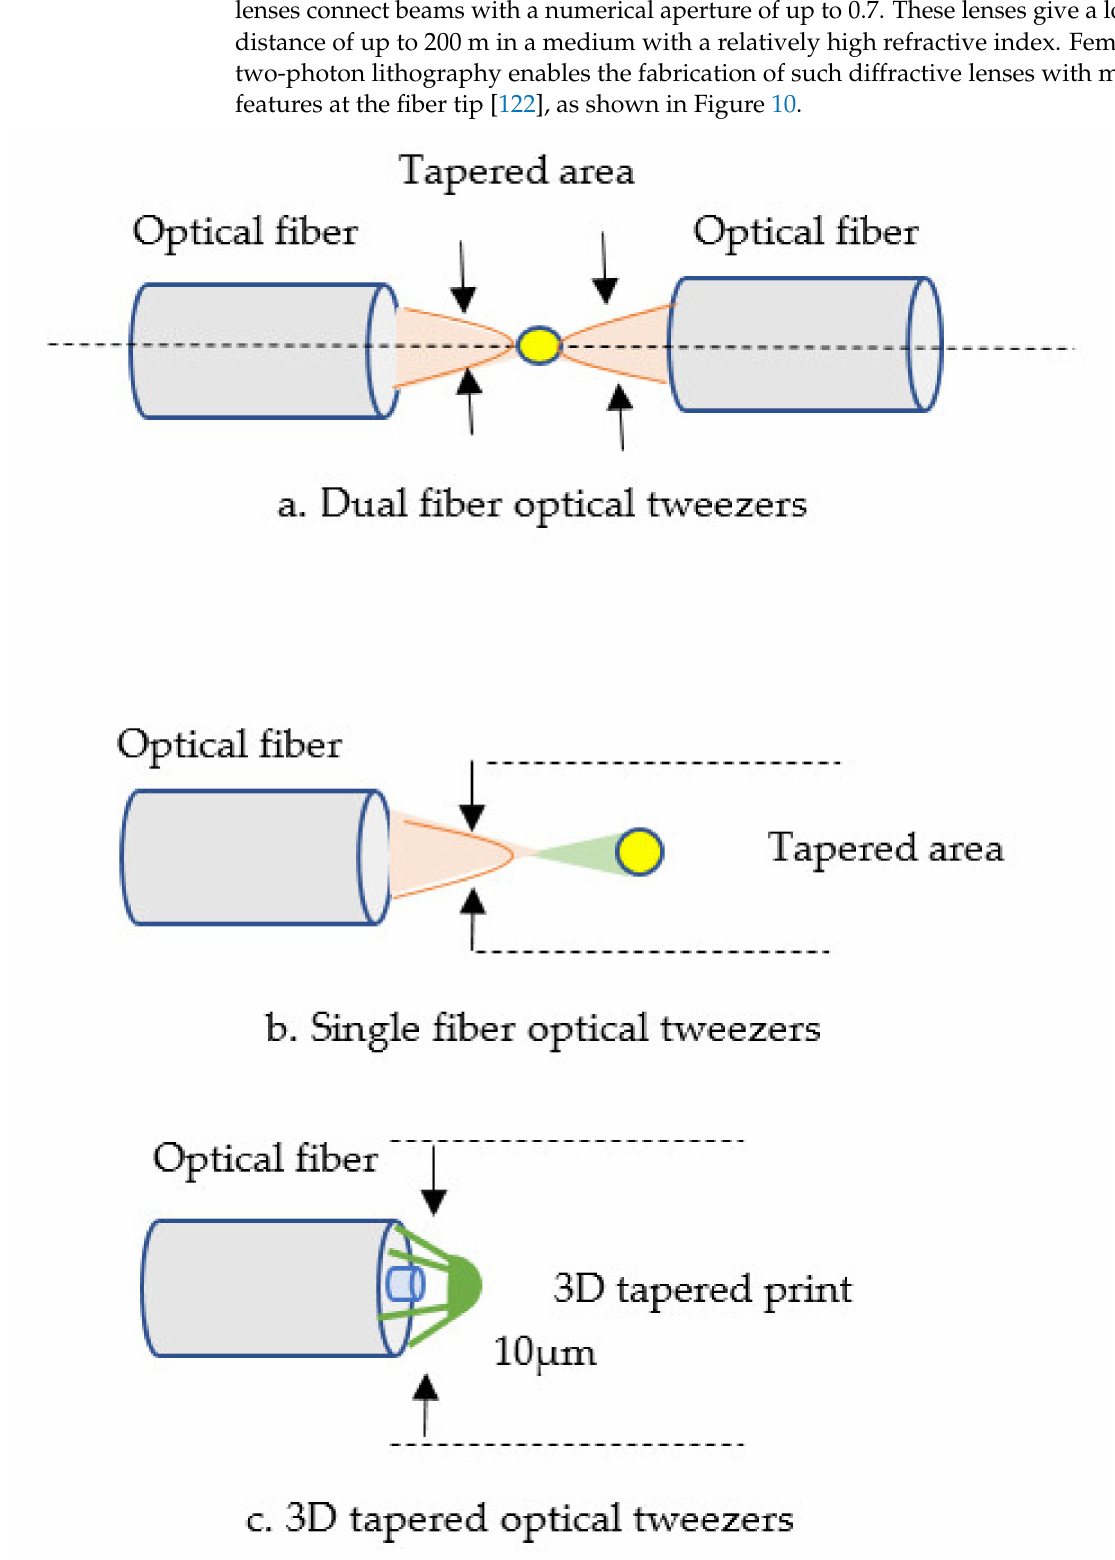
Figure 10. Tapered fiber optic based on optical tweezer structures